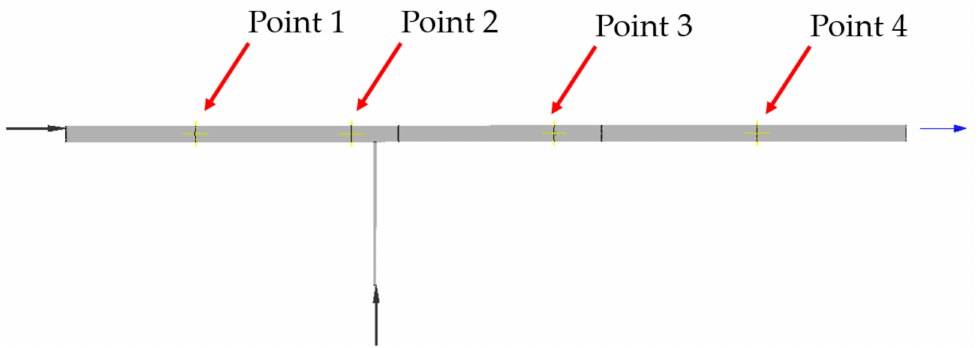
Figure 5. Temperature measuring